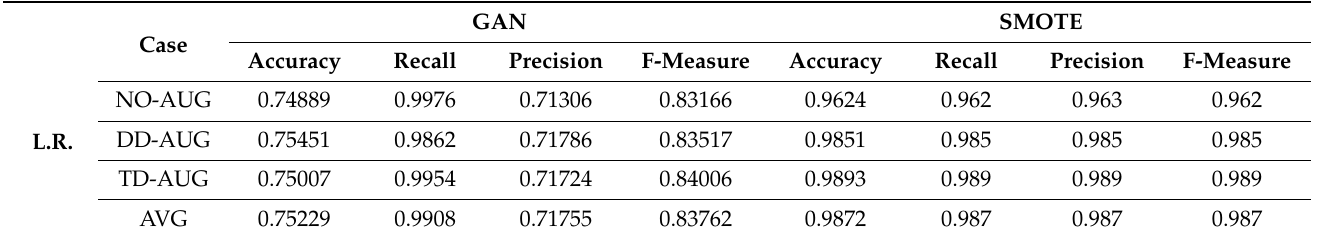
Table 5. Evaluation of L.R. Classifier for NO-AUG, DD-AUG and TD-AUG.